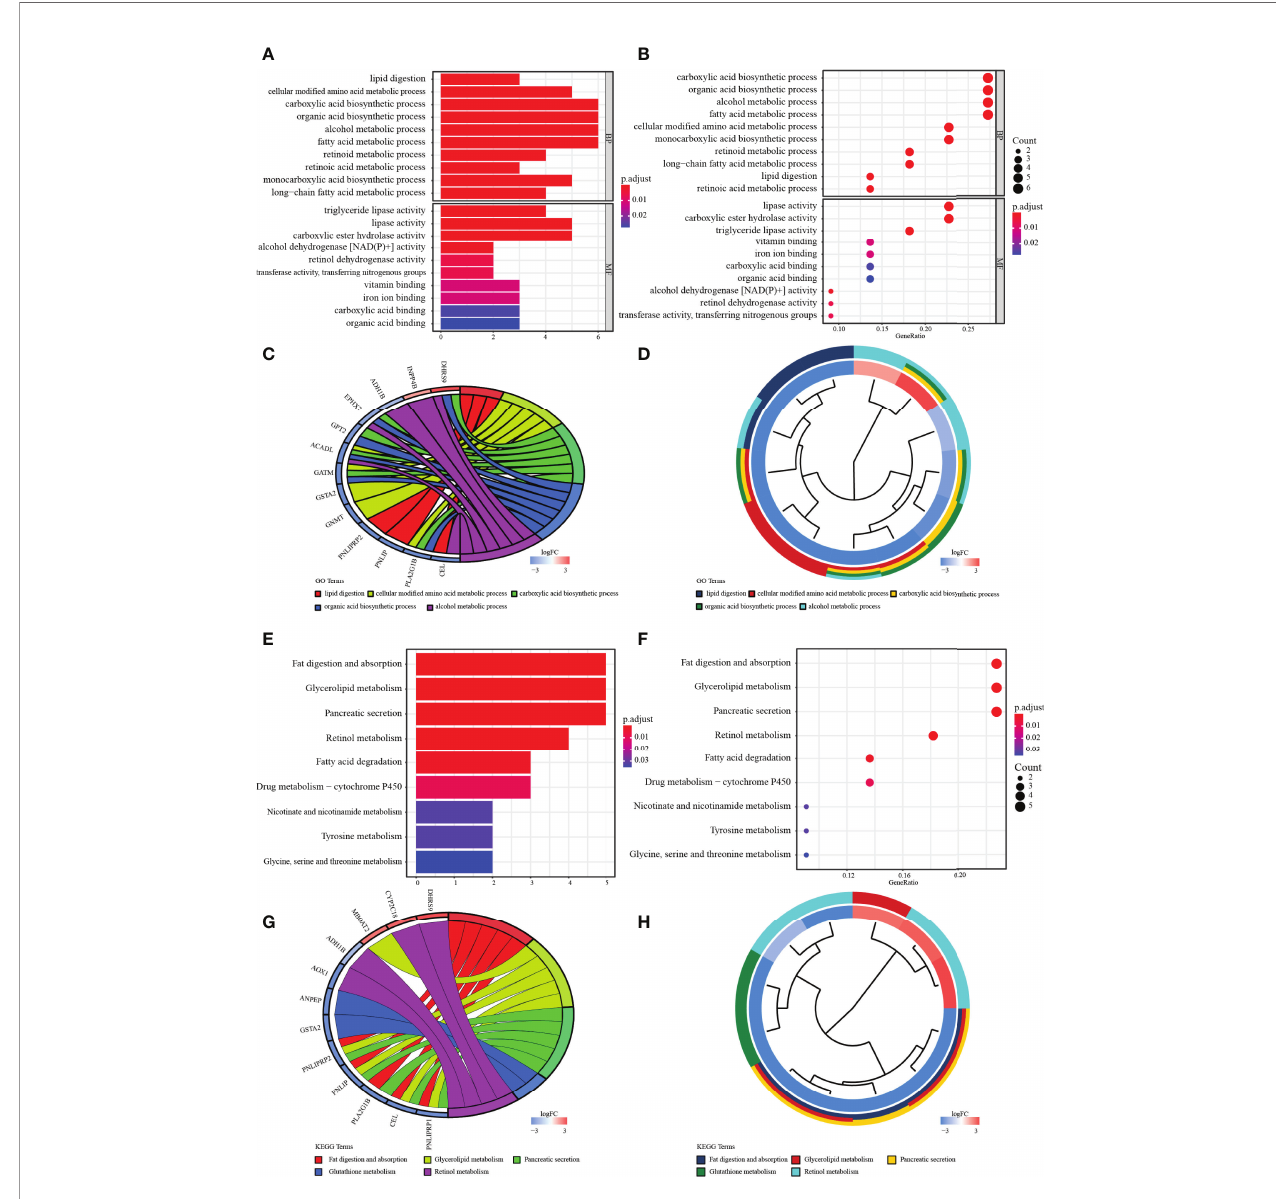
FIGURE 3 | Enrichment analysis. (A, B) The bar and bubble charts of GO terms are enriched in BP and MF. (C, D) The chord with cluster plots shows the top 5 GO terms and the corresponding enriched genes. (E, F) The bar and bubble plots of KEGG enriched terms. (G, H) The chord with cluster maps shows the top 3 KEGG terms and the corresponding enriched genes. The false discovery rate (FDR) <0.05 of all terms was signi fi